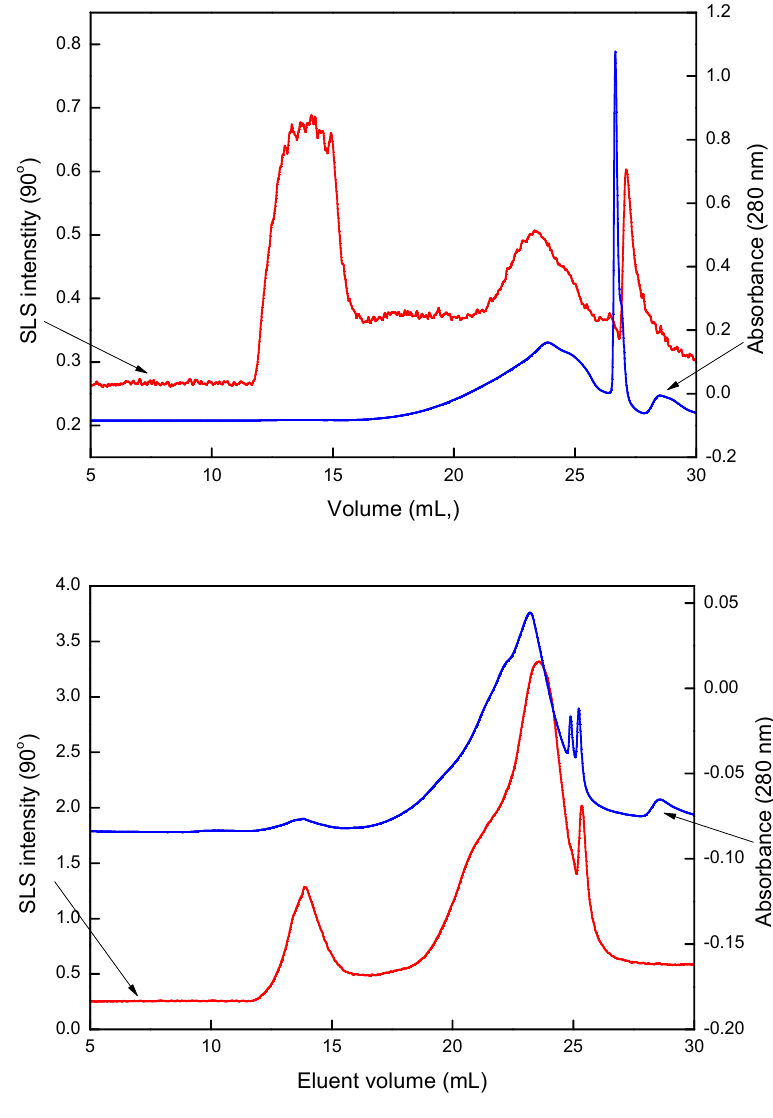
Figure 4. Size exclusion chromatograms of the bean extracts at pH 7, showing data from a static light scattering (SLS) detector (angular intensity at 90°) and an ultraviolet (UV) absorbance detector (absorbance at 280 nm). The top chromatogram corresponds to a 5% solution of the extract; the bottom one to the material desorbed from the SDS treatment of the cream of a BE-stabilized oil-in-water emulsion at pH 7.